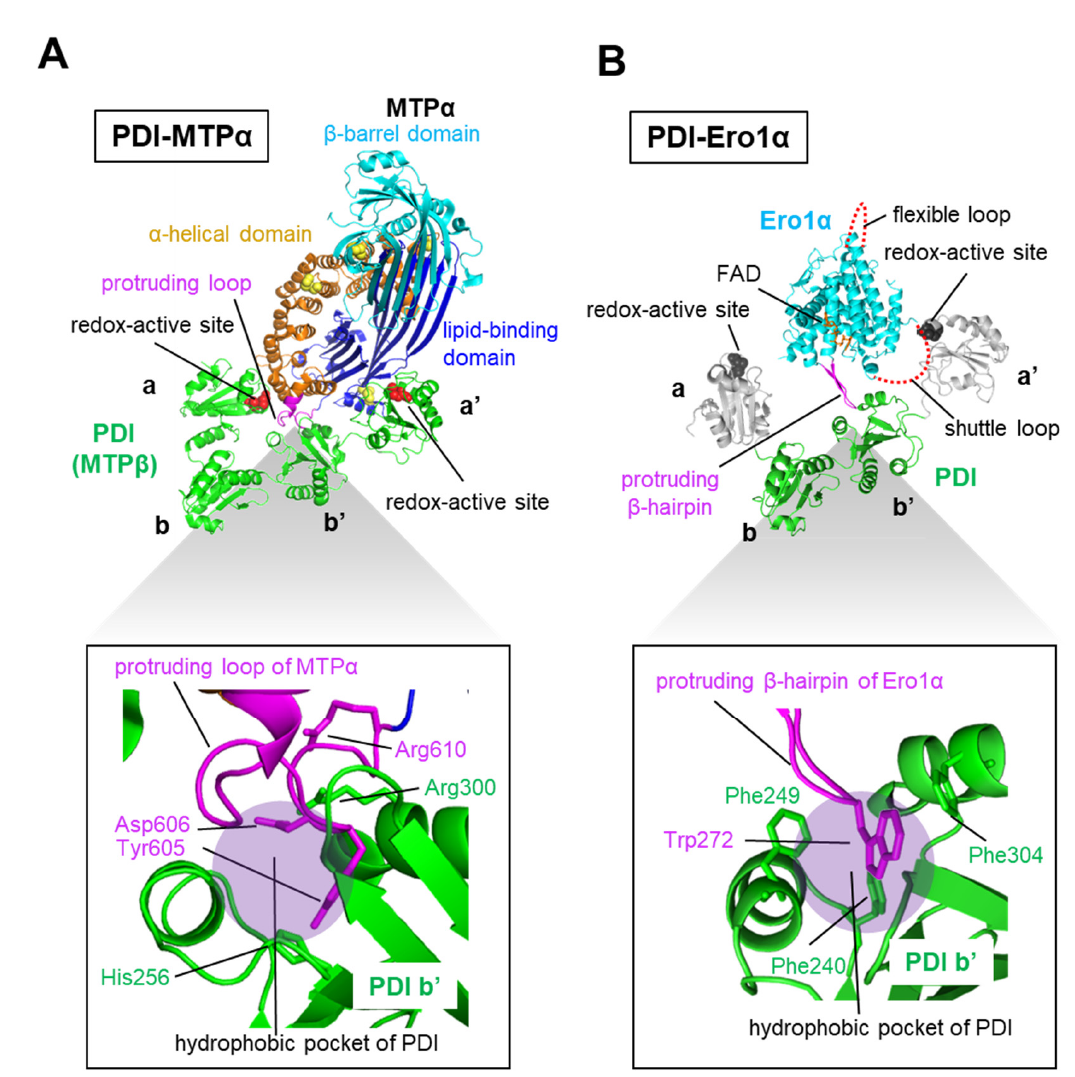
Figure 7. The protruding aromatic ring of human microsomal triglyceride transfer protein (MTP) α or human Ero1 α is in close contact with aromatic or hydrophobic residues in the PDI b’ domain. ( A ) Crystal structure of the PDI-MTP α complex (PDB code: 6I7S). Upper panel, PDI, β -barrel domain, α -helical domain, and lipid-binding domain of MTP α colored green, cyan, orange, and blue, respectively. Redox-active sites of PDI and disulfide bonds in MTP α are indicated by red and yellow spheres, respectively. Lower panel, interaction sites between the hydrophobic pocket in the b’ domain of PDI (shadow) and a protruding loop of MTP α (magenta). ( B ) Docking model of the PDI-Ero1 α complex predicted by docking simulation analysis of the molecular surface, electrostatic potential, and hydrophobicity complementarity, weighted by the conservation of interacting residues using the sysimm.ifrec.osaka-u.ac.jp/surFit/index.html website. Human Ero1 α (PDB code: 3AHQ) and the b - b’ domain of human PDI (PDB code: 2K18) were docked. The b - b’ domain, Ero1 α , flavin adenine dinucleotide (FAD) cofactor, and protruding β -hairpin in Ero1 α are colored green, cyan, orange, and magenta, respectively. The putatively positioned catalytic domains ( a and a’ ) are colored gray. The disulfide bond of the redox-active site in the a’ domain is formed by catalytic sites on the shuttle loop of Ero1 α , which is shown as a red dotted line. The lower panel shows a close-up view of the interaction sites between the hydrophobic pocket in the b’ domain of PDI (shadow) and the protruding β -hairpin of Ero1 α (magenta).